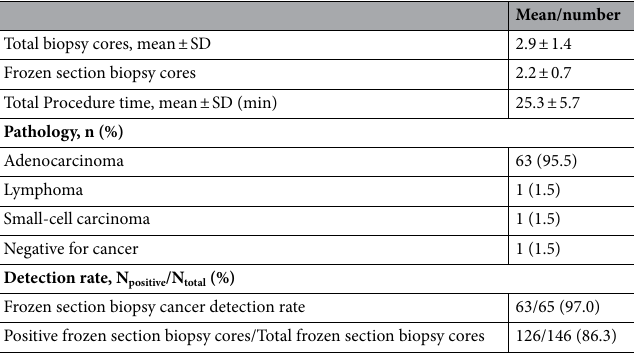
Table 2. Results of MRI–US fusion-targeted prostate biopsy with utilization of frozen section biopsy in high- risk prostate cancer. MRI, magnetic resonance imaging; US, ultrasonography; SD, standard